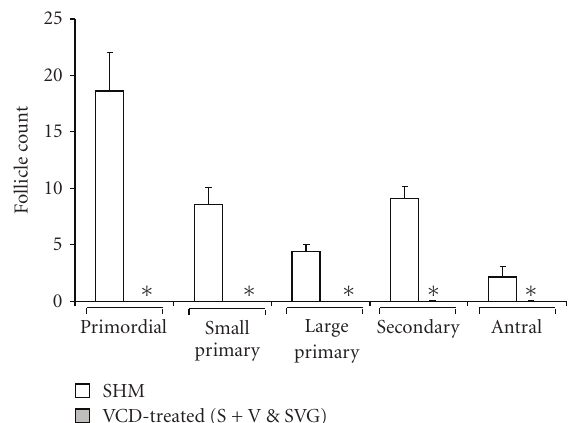
Figure 5: E ff ect of VCD-treatments versus controls on follicle type counts in mouse ovaries. Columns represent the mean total number of follicles counted in every 20th section (5- μ m) of each ovary and error bars indicate the SEM for n = 11 SHM and n = 23 VCD- treated mice (S + V and SVG). Data from S + V and SVG groups were determined not to be significantly di ff erent from one another, based on a t test, and were pooled for comparison against SHM controls. ∗ indicates significance ( P < . 0001) for SHM-versus VCD- treated mice for each follicle type using the Mann-Whitney test.